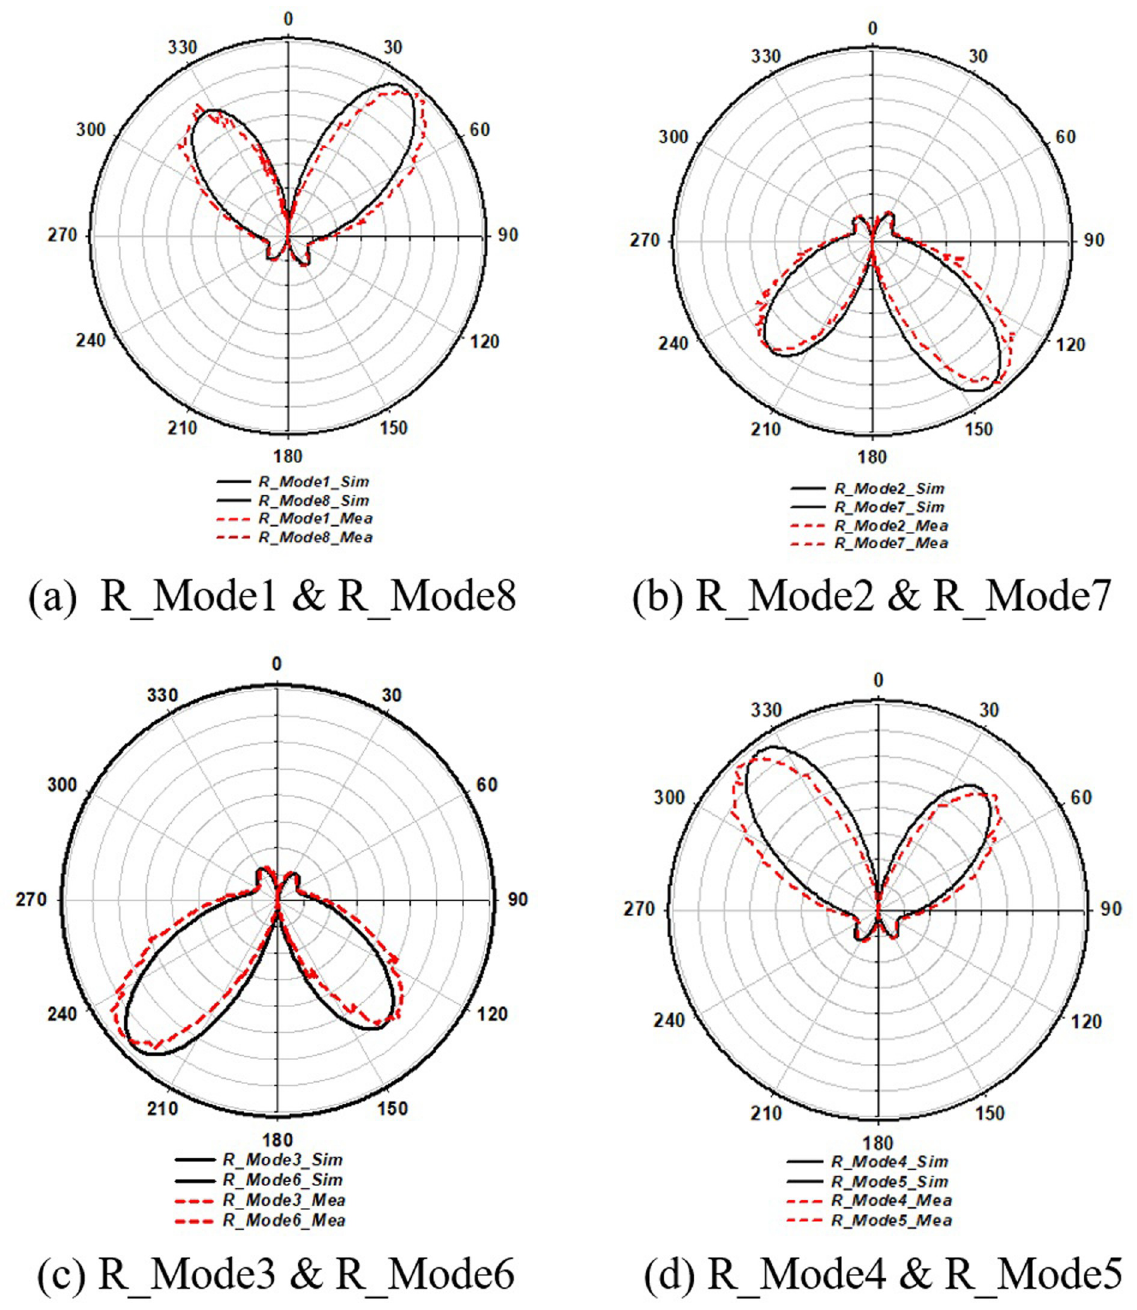
Fig 7. Simulated and measured polarization results showing radiation pattern of both 28GHz and 38GHz on XOY-E-Plane.